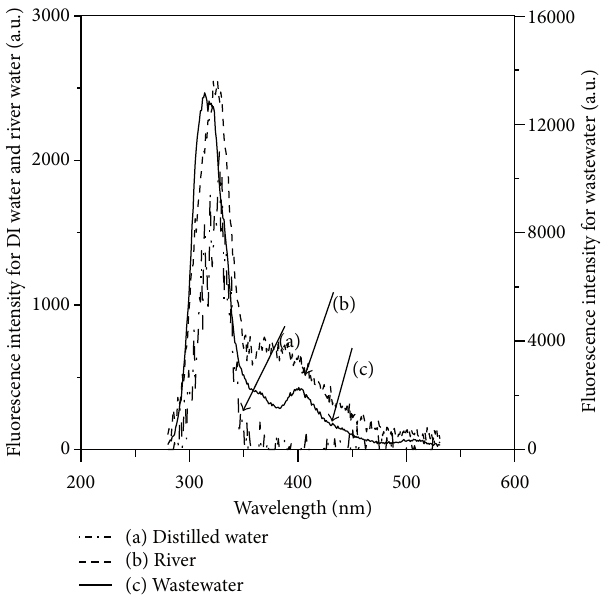
F 1: Synchronous �uorescence spectra of (a) DI water (b) river water, and (c)